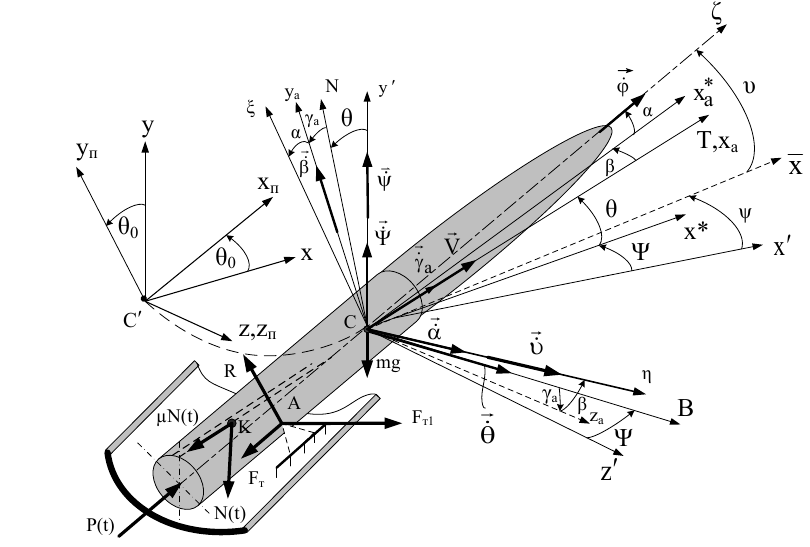
Figure 2 – Coordinate systems and angles that determine their mutual positions on the site of the spatial movement of the projectile in a tubular